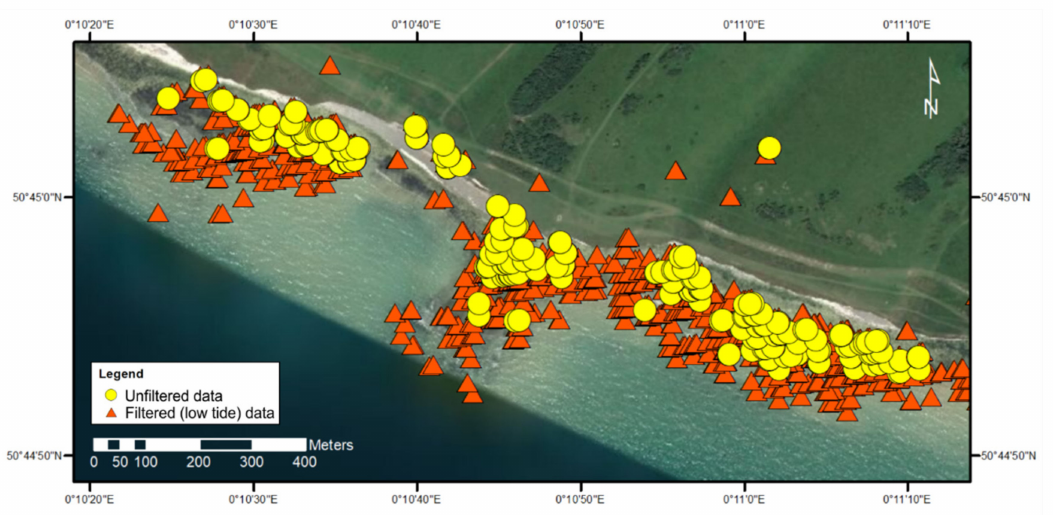
Figure 5. Flagsta ff Point research site showing an example of the di ff erence in the point density between processed data from every scene recorded within the time period of interest (yellow circles) and processed data filtered to only include scenes when the tide was low (orange triangles). In this example, the unfiltered data produced only 233 PS points, whilst the data filtered to include the low tide produced 935 PS points. Data overlain on ArcGIS Online World Imagery (Service Layer Credits: Esri, HERE, Garmin, © OpenStreetMap contributors and GIS user community. Source: Esri, DitalGlobe, GeoEye, Earthstar Geographics, CNES / Airbus DS, USDA, USGS, Aero GRID, IGN and GIS User